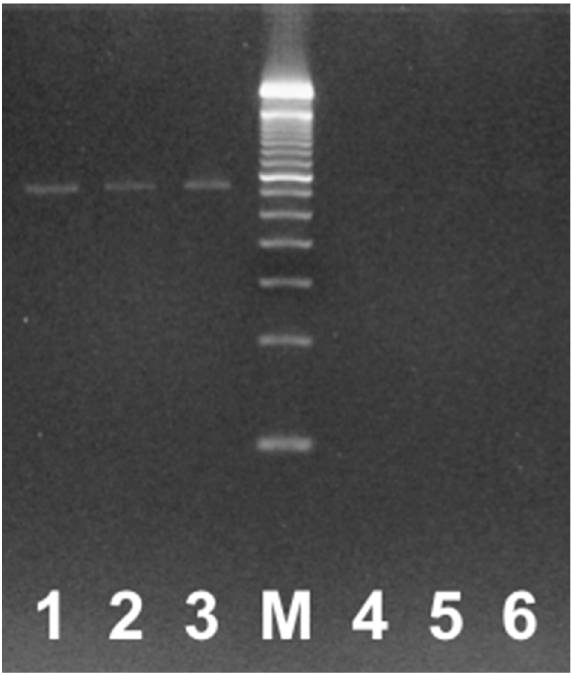
Figure 1. Sensitivity of the ITS1 cPCR assay for L. braziliensis, gel electrophoresis of conventional PCR result, using the Schönian method. Lanes 1, 2 and 3 are 100 copies/PCR; lane M is the 100bp ladder size standard, lanes 4, 5 and 6 are 10 copies/PCR.